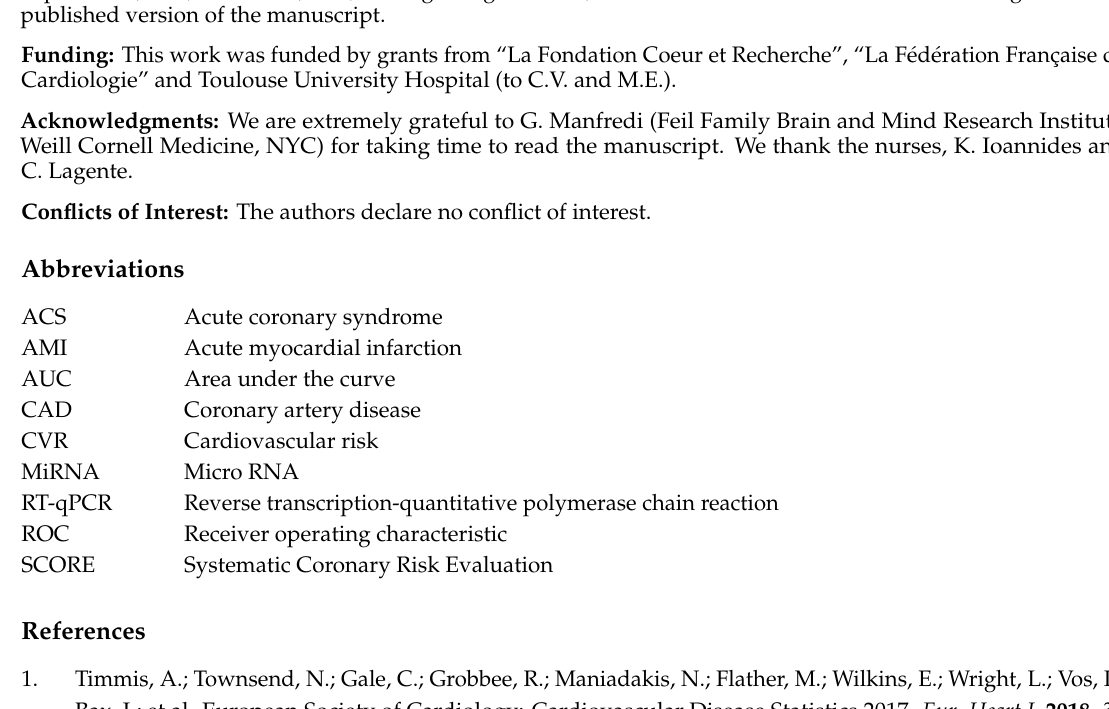
Table S1. Baseline characteristics of the derivation cohort, Table S2. - ∆ Ct values and fold changes of each detected circulating miRNA (144 / 758) in ACS and control groups, Table S3. Interaction of medical treatment with miRNA expression level. Table S4. Receiver operating characteristic (ROC) curve analysis comparing predictive of selected circulating miRNAs individually or in